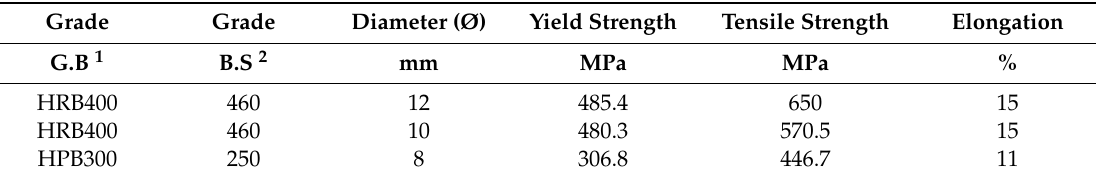
Table 2. Material properties of steel reinforcement.